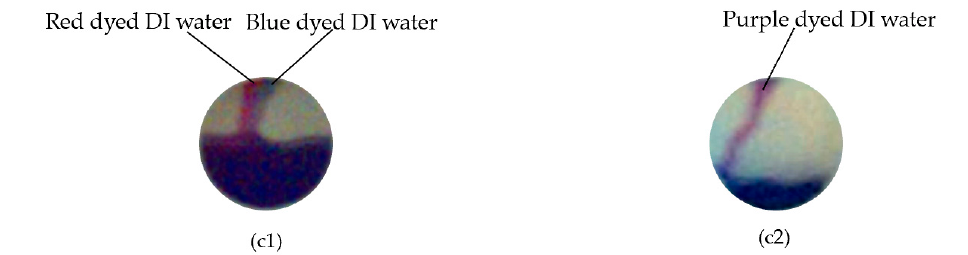
Figure 6. Photo images showing the experimental results: ( a ) for the Y-shaped mixer; ( b ) for the jet mixer; ( c ) the images of fluid entering collecting chambers: ( c1 ) for the Y-shaped mixer chambers and ( c2 ) for the jet mixer. The rotation of the platform was brought to a complete stop at t = 5s.